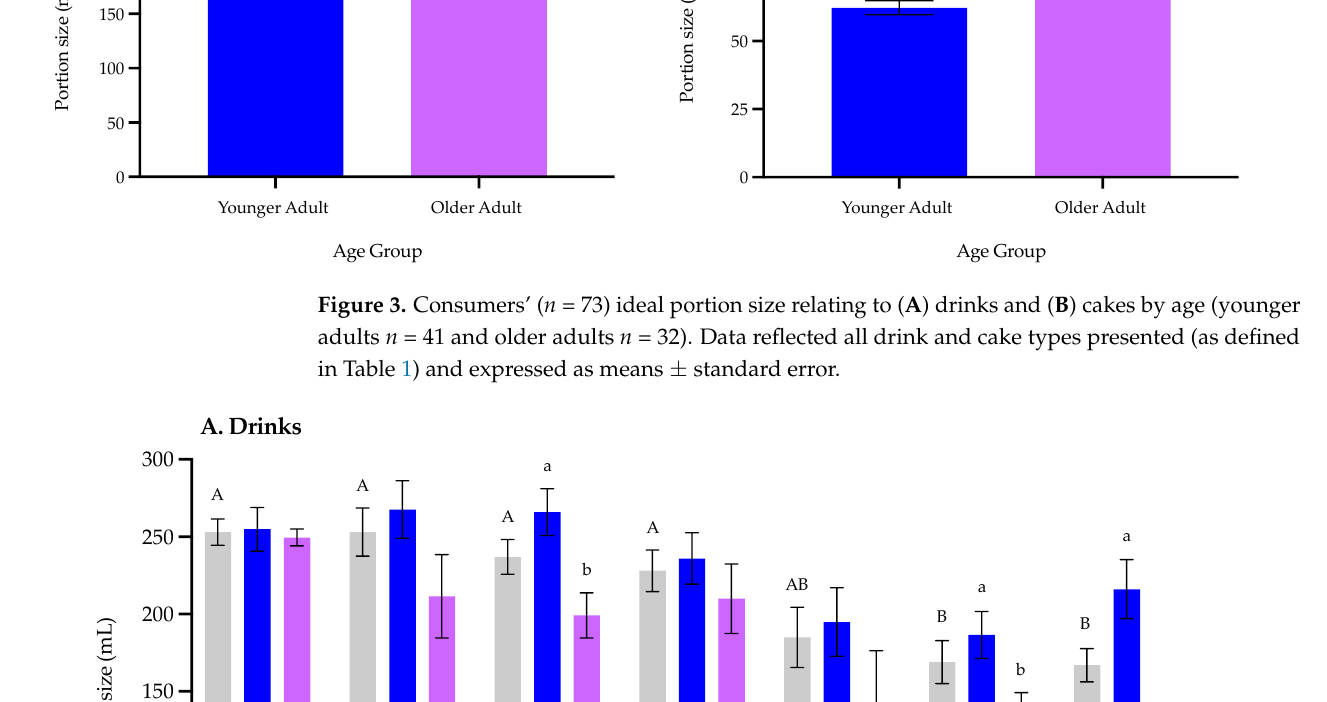
portion size compared with other cake types (68 – 43 g) (Figure 4).